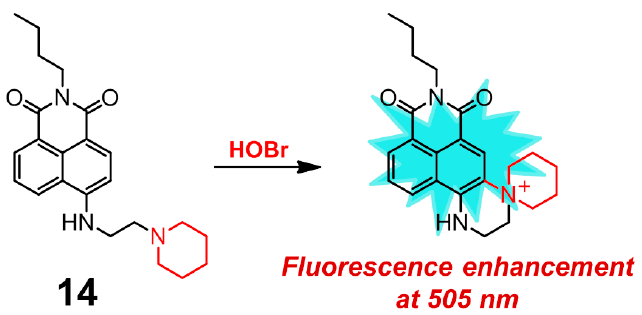
Figure 14. 1,8-naphthalimide derivative 14 for selective detection of HOBr. Table 1. Summary of the fluorescent probes for HOBr.